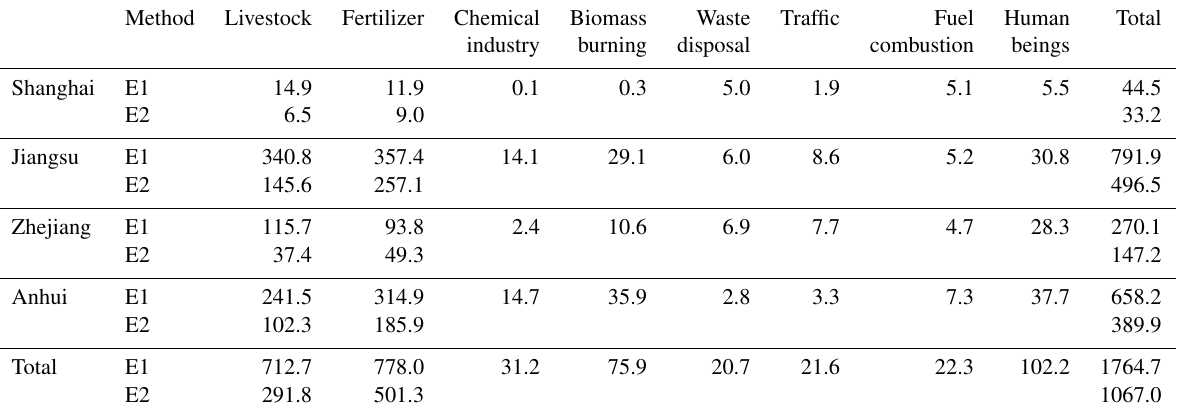
Table 2. Two anthropogenic NH 3 emission inventories in the YRD region in 2014 (Gg). Method Livestock Fertilizer Chemical Biomass Waste Traffic Fuel Human Total industry burning disposal combustion beings